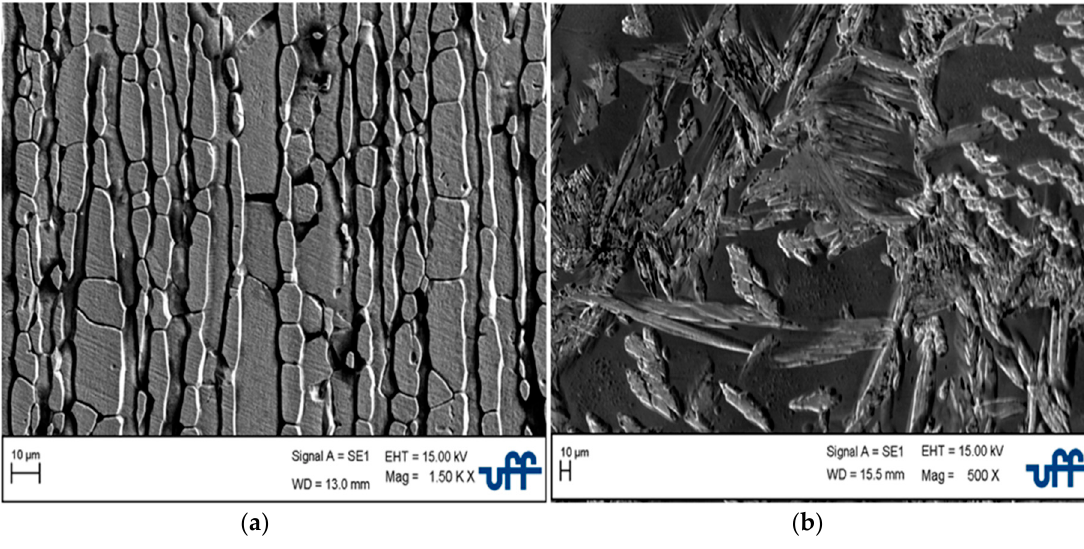
Figure 18. Microstructural aspects after electrochemical test. SAF 2507—High heat input. ( a ) Base metal, ( b ) Weld region.